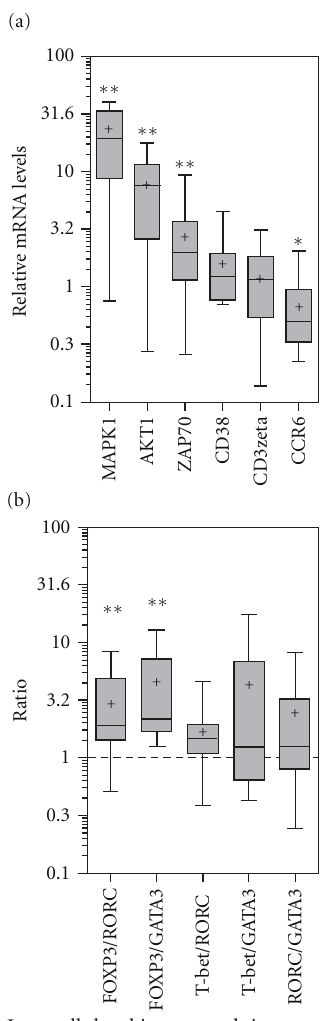
Figure 1: (a) Intracellular kinases and immunoreceptors gene expressions levels. RNAs extracted from PBMC of SLE patients ( n = 13) and controls ( n = 4) were reverse transcribed, and the gene expression levels were determined by qRT-PCR using gene-specific primers for indicated genes and GAPDH to normalize the mRNA expression (Materials and Methods, Supplementary Materials, and Table 2). Proportion of transcript present in the samples was calculated using the relative quantification 2 − ΔΔ Ct scheme. Control samples were used as comparative calibrator. Final results represent the relative amount of amplicon in patient’s sample (fold change) to the mean level of the transcripts in the control samples. In the figure, results are represented in box plots given the median (horizontal bars within boxes), the mean (cross points); box limits correspond to quartiles, and vertical lines indicate the 5– 95 percentile range. Results are represented in a log 10 scale, and the indicated numbers are the antilog values. Significance levels set at P values < 0.05. AKT1, MAPK1, and ZAP70 gene expressions were increased in SLE patients compared with controls (Wilcoxon Signed Rank test: P = 0 . 0064, P = 0 . 0012, P = 0 . 0024). Gene expression of CCR6 was decreased in SLE patients compared with controls (Wilcoxon Signed Rank test: P = 0 . 0398). (b) T-helper transcription factors gene expression ratios in SLE patients. Results are expressed as indicated in (a). FOXP3/RORC ratio in SLE patients versus controls (Wilcoxon Signed Rank test, P = 0 . 0042). FOXP3/GATA3 ratio in SLE versus controls (Wilcoxon test, P = 0 . 0017).